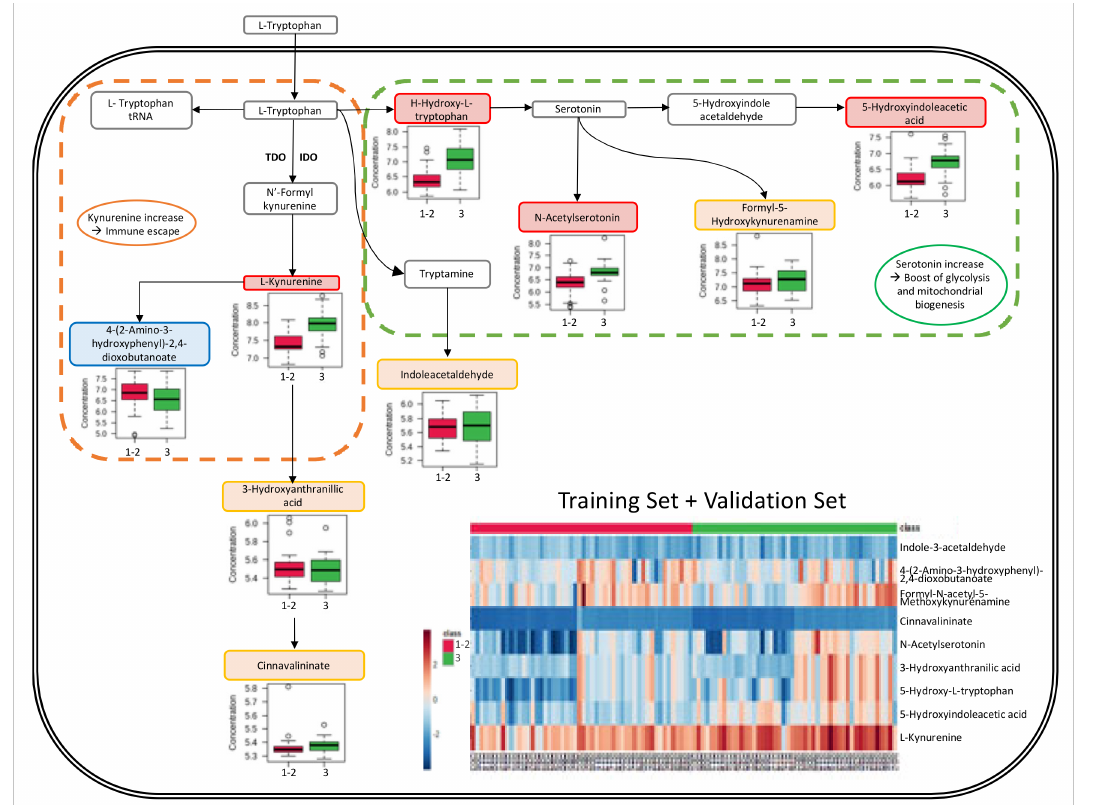
Figure 5. Schematic representation of metabolic pathway changes. The tryptophan pathway illustra- tions have been adapted from the Small Molecule Pathway database (https://www.smpdb.ca/view/ SMP0000063, accessed on 21 December 2022). Box plots illustrate the relative concentration of the main tryptophan catabolites in high-grade (grade III—green boxes) and low-grade (grade I–II—red boxes) groups. Metabolite names are shown in colored boxes: red boxes relate to higher concentra- tions in high-grade samples; orange boxes to equivalent concentrations in high-grade and low-grade samples; green boxes to lower concentrations in high-grade samples. Heatmap representations of relative concentrations of tryptophan catabolites are shown for all samples (together for the training set and the validation set). Results of the low-grade (grade I–II—red labels on the top line) group are positioned in the left part of the heatmap and those of the high-grade (grade III—green labels) group in the right